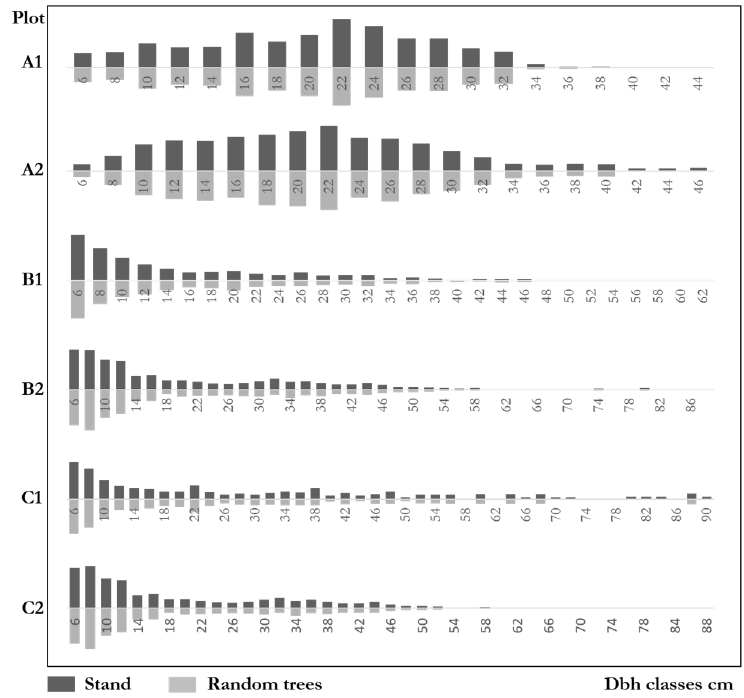
Figure 8. Diameter distributions of stands and random